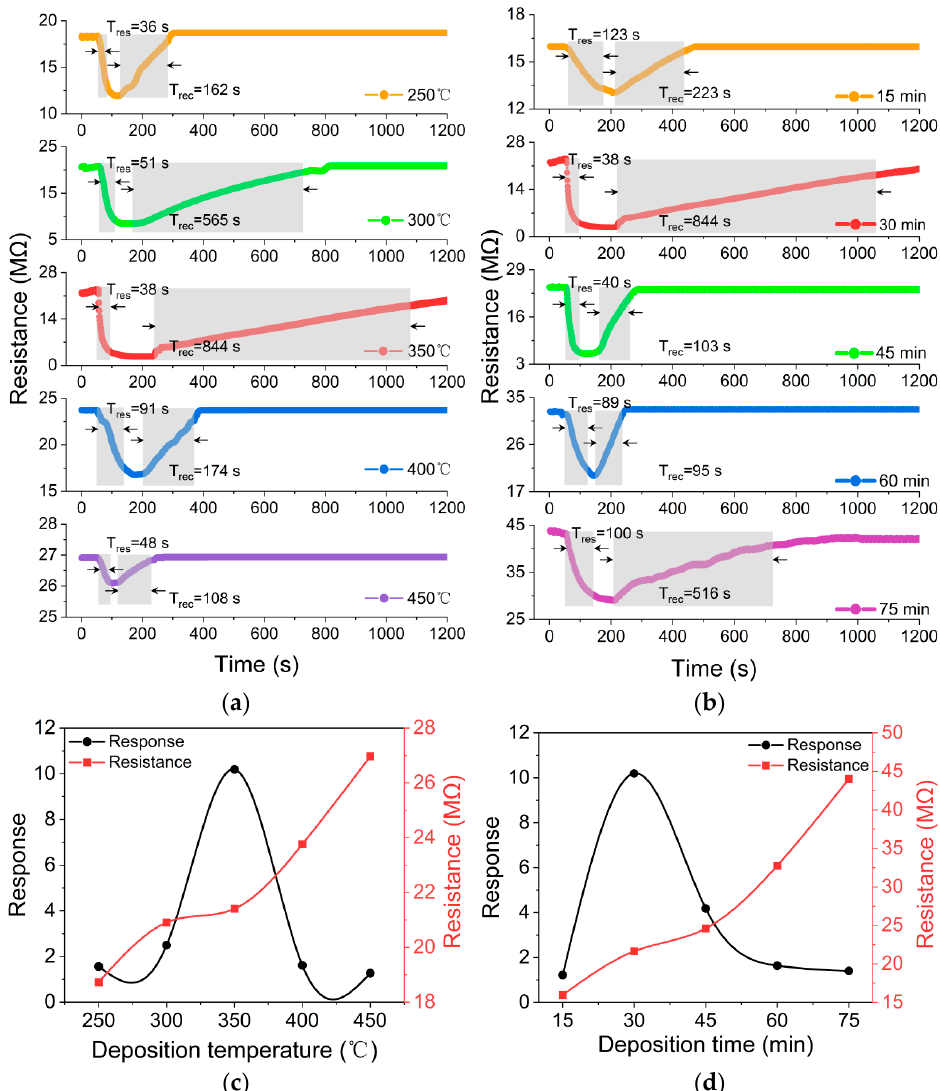
Figure 6. Gas-sensing properties of BP thin films: ( a ) Thin films deposited under various temperatures; ( b ) Thin films deposited under various times; ( c ) Influence of deposition temperature; ( d ) Influence of deposition time.